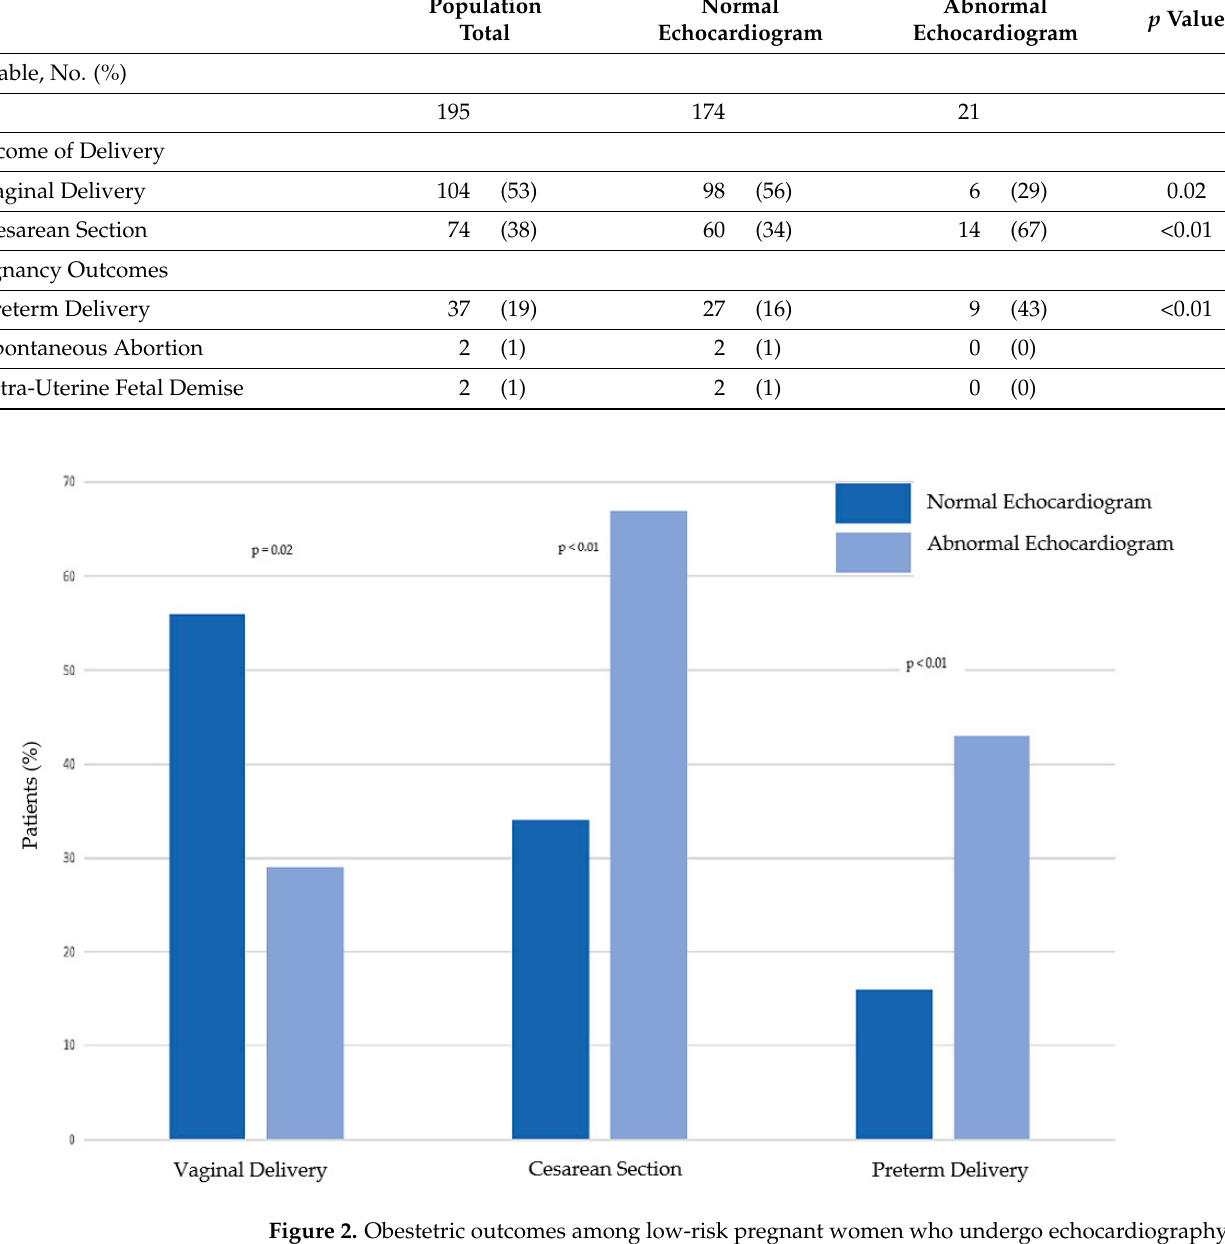
Table 5. Obstetric outcomes among low-risk pregnant women by echocardiography result.